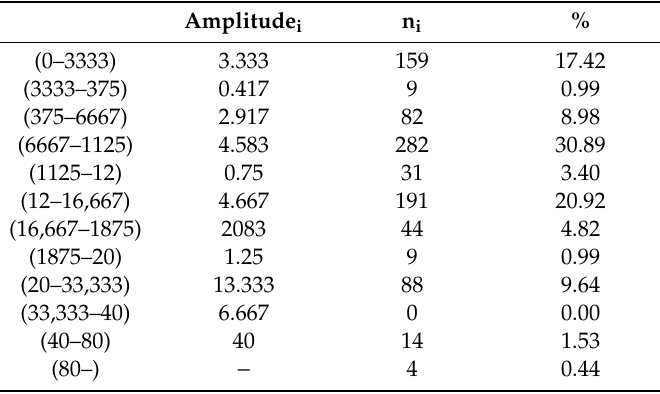
Table 6. Artificial